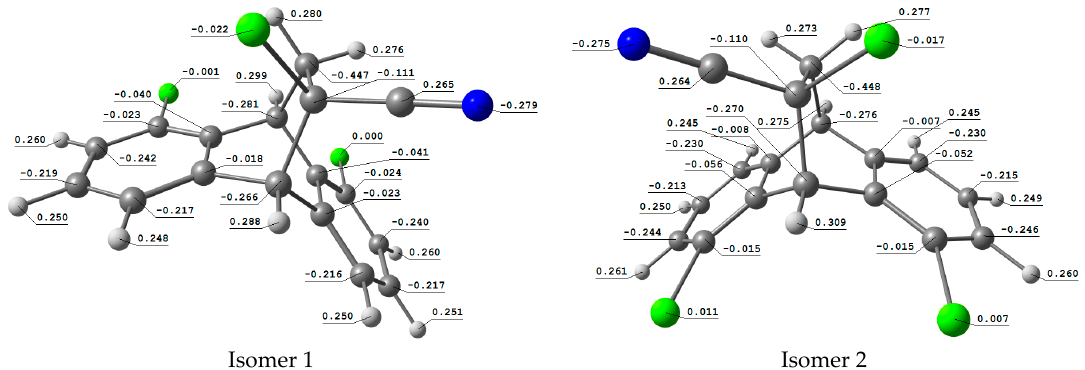
Figure 5. Atomic charge distributions at different atomic sites of regioisomers 1 and 2 .